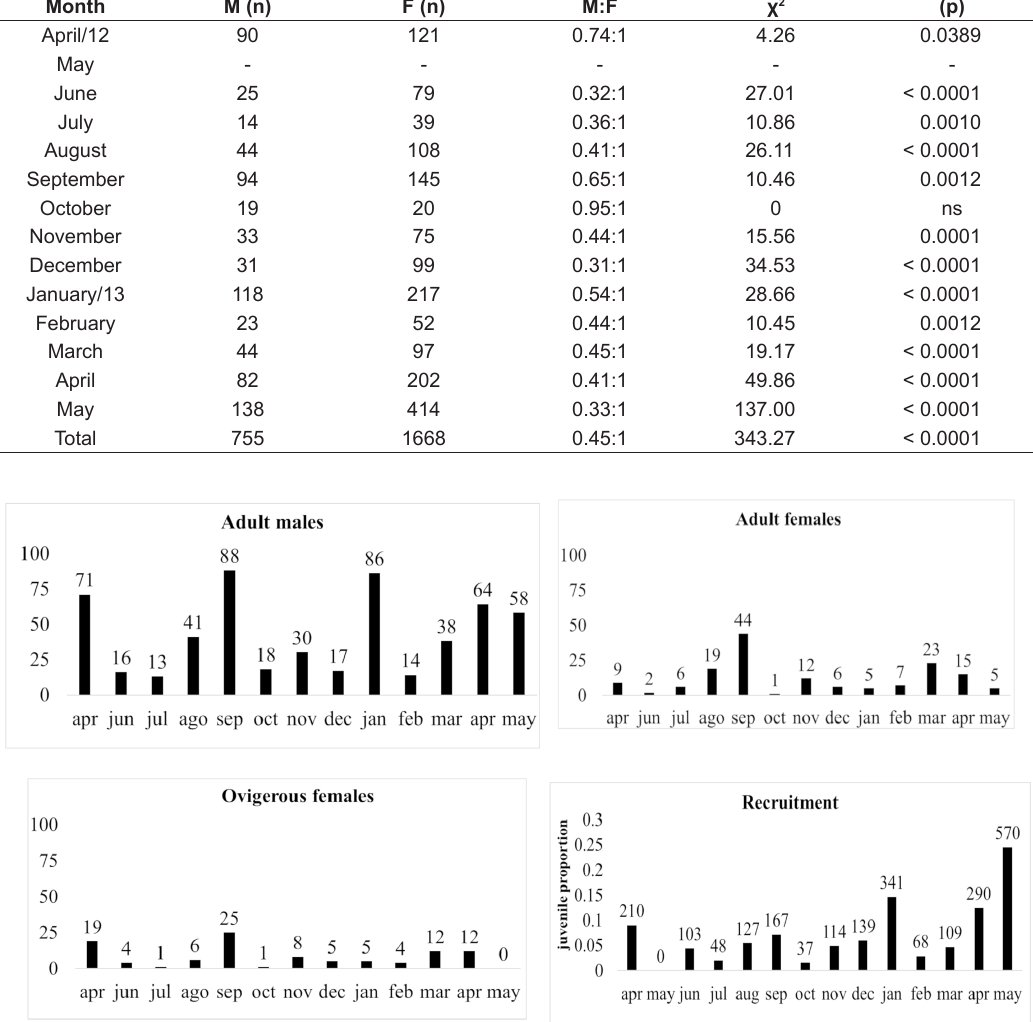
Table 3. Sex-ratio (M:F), Chi-square ( χ 2 ) and significant probability by month (p), in a population sampled in Miranda dam (MG), between April/2012 and May/2013. (M: Male; F: Female; ns: non significant).